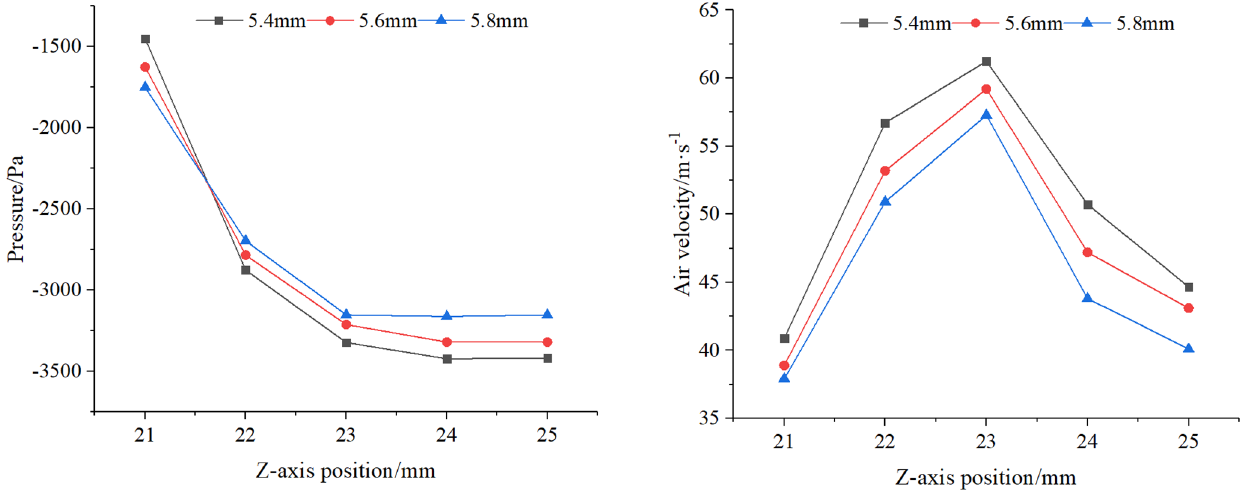
Figure 13. Air pressure and velocity at different inlet diameters of the seed disk holes.